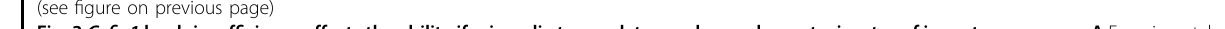
Fig. 3 Cy fi p1 haploinsuf fi ciency affects the ability if microglia to regulate number and apoptosis rates of immature neurons. A Experimental setup, Mac-1-Sap was present in wild-type hippocampal progenitor cultures from 2 h after isolation until 3 days in vitro. Dose – response curves of microglial death after Mac-1-SAP administration show near-complete depletion of Iba1 + microglia was achieved within 48 h ( n = 6). B Cultures where microglia were depleted ( n = 4) showed a higher proportion of DCX + cells than controls ( n = 4). C Correspondingly, the fraction of DCX cells undergoing apoptosis, as marked by cleaved-caspase 3 staining, was signi fi cantly decreased in the absence of microglia. D The proportion of nestin + cells was unaffected by microglia depletion. E Experimental setup, membrane inserts containing wild-type microglia prepared from P7 – 8 brain were added to cultures 2 h after progenitor isolation and were present throughout the remainder of the experiment. Due to the experimental conditions, no cell – cell contact between microglia and progenitors was possible, but secreted factors were free to diffuse. F The presence of microglia- containing inserts ( n = 8) signi fi cantly decreased the proportion of DCX expressing cells compared to controls ( n = 8). G Conversely, the added microglia signi fi cantly increased apoptosis in DCX + cells. H No effect was seen in nestin expressing cells. I Experimental design, wild-type hippocampal progenitors were exposed to conditioned medium from either wild-type or Cy fi p1 + / − microglia. J In wild-type cultures, conditioned medium from wild-type microglia induced a signi fi cant reduction in the proportion of DCX + cells, whereas medium from Cy fi p1 + / − microglia was unable to do this ( n = 4 in all conditions). K An inverse pattern was seen in neuronal apoptosis where wild-type microglia medium increased apoptosis in DCX + immature neurons but Cy fi p1 + / – medium did not. L Nestin + cells were not signi fi cantly affected by the presence of microglial factors. M Experimental design, Cy fi p1 + / − hippocampal progenitors were exposed to conditioned medium from either wild-type or Cy fi p1 + / − microglia. N As seen in the wild-type cultures, a signi fi cant decrease in DCX + cells was observed only after stimulation with medium from wild-type microglia ( n = 4 in all conditions). O Similarly, medium from Cy fi p1 + / − microglia was unable to induce apoptosis in Cy fi p1 + / − progenitors. P Again, the nestin + population was unaffected. All data are shown as mean ±